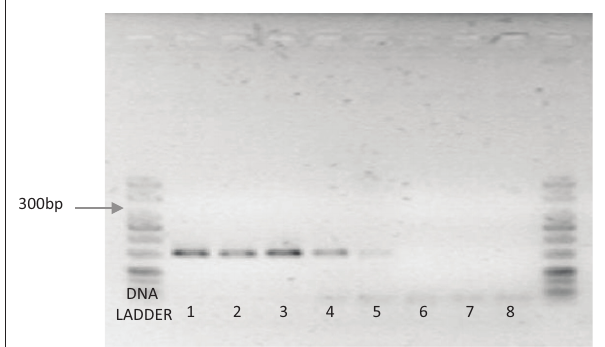
FIGURE 2: Agarose gel image showing PCR amplicon bands of the specimens. The ~300 bp band is the target band size for Filoviruses.